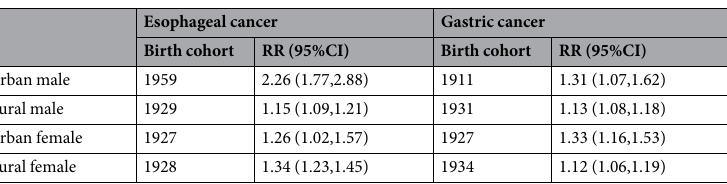
Esophageal cancer Gastric cancer RR (95%CI)